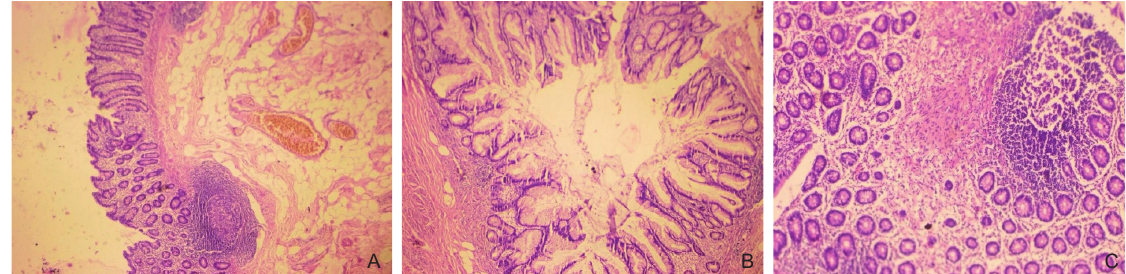
Figure 2 (A) Mircroscopic features of the appendicular mucocele (hematoxylin and eosin stain) showed lymphoid follicle and mucinous hyperplasia; (B) Microscopic features of the appendicular mucocele (hematoxylin and eosin stain) showed a mucous-filled appendix; (C) Mircroscopic features of the appendicular mucocele (hematoxylin and eosin stain)- lymphoid follicle and inflammatory cell infiltrate.